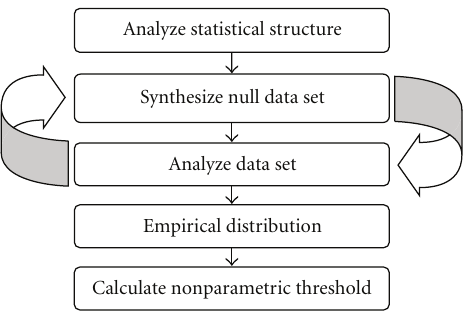
Figure 1: Flowchart containing the main building blocks for nonparametric analysis of single-subject fMRI